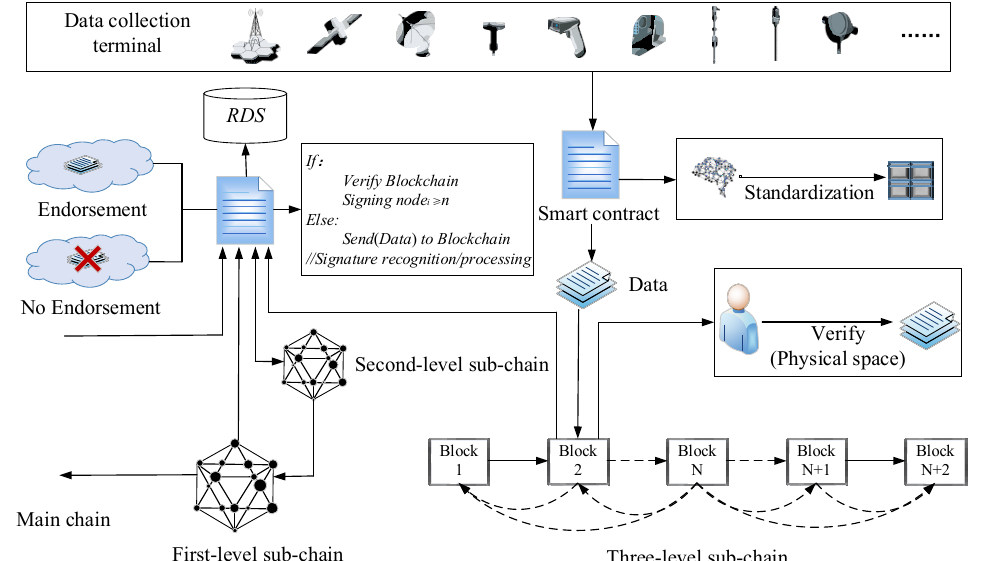
Figure 3. Schematic diagram of trusted chaining mechanism.